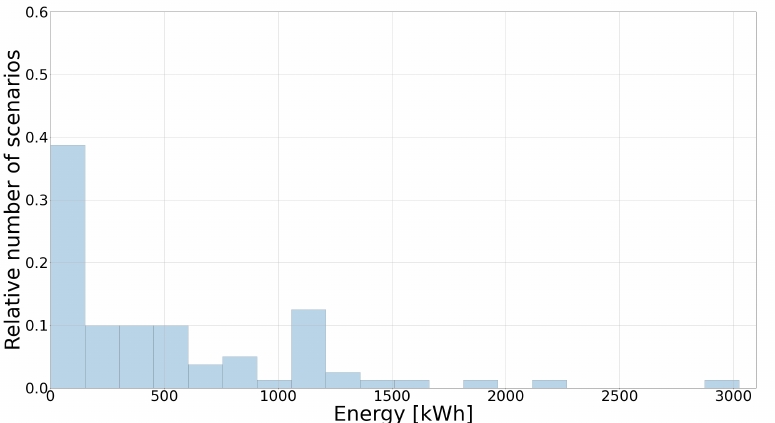
Figure 11. Histogram with PV generation time series shifted backwards by one